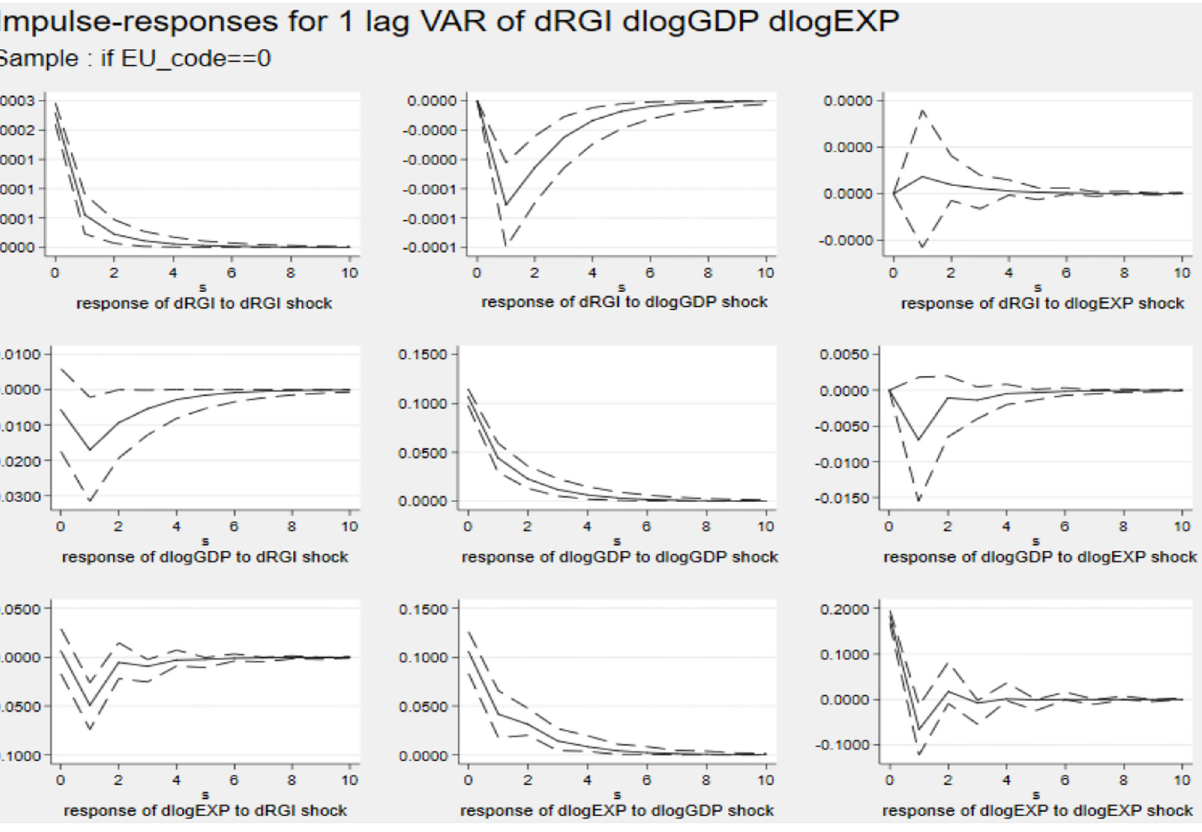
Fig 4. Impulse response diagram in Cluster 3. Notes : Errors are 5% on each side generated by Monte-Carlo with 2000 reps.